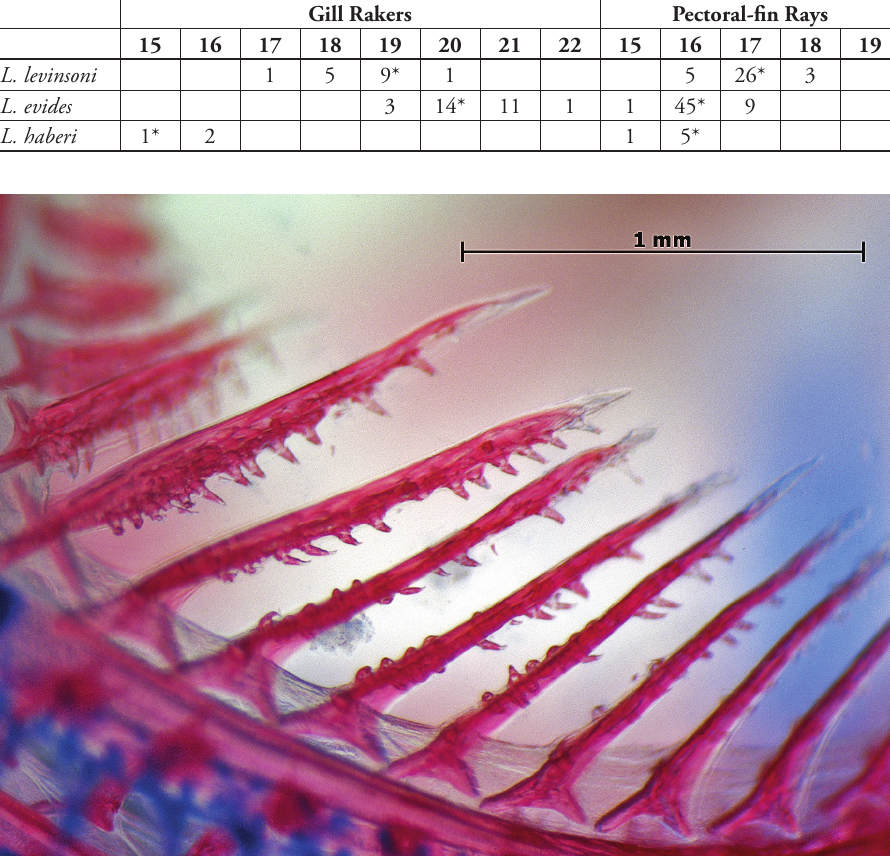
Table 2. Frequency distributions of gill rakers on first arch and left and right pectoral-fin rays in Lipo- gramma levinsoni sp. n., L. evides , and L. haberi sp. n. Counts for the holotype and three paratypes of L. evides are included from Robins and Colins (1979). Counts of gill rakers and pectoral-fin rays for a fourth paratype of L. evides, ANSP 134330, were not given in the original description. The fifth and smallest paratype, ANSP 134332, is a specimen of L. levinsoni, and counts of that specimen made in this study are included. An asterisk indicates count of gill rakers or left pectoral-fin rays in holotype. Gill Rakers